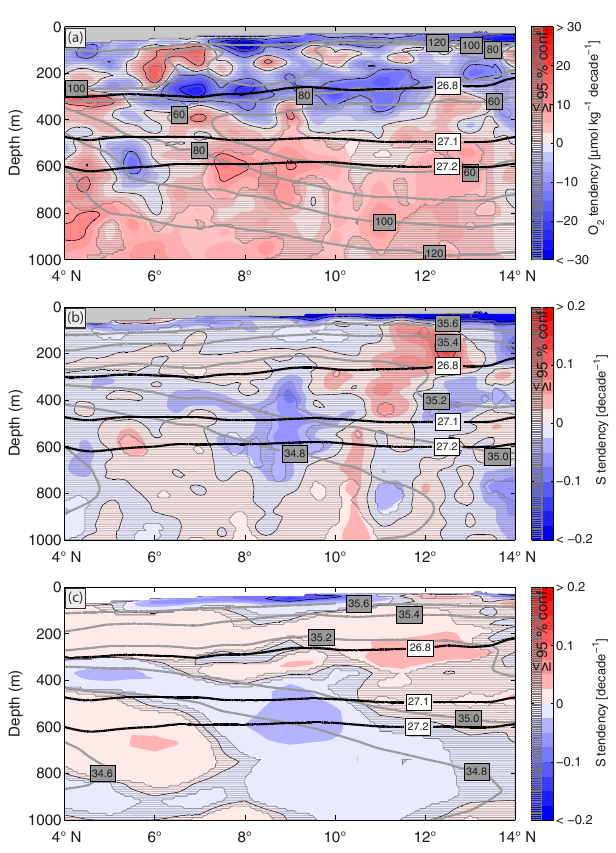
Figure 6. Depth–latitude section of the linear trend (filled contours) of (a) oxygen and (b, c) salinity in the ETNA along 23 ◦ W. Pan- els (a) and (b) were calculated from repeat shipboard observations in the period 2006–2015. Panel (c) was calculated from Argo float observations in the period 2006–2015. All calculations were done on density surfaces with subsequent projection onto depth surfaces. Gray-hatched areas mark non-significant regimes with respect to 95% confidence. Mean fields of oxygen and salinity, respectively, are given as gray contours. Thick black contours define isopycnal surfaces 26.8, 27.1 and 27.2kgm − 3 .